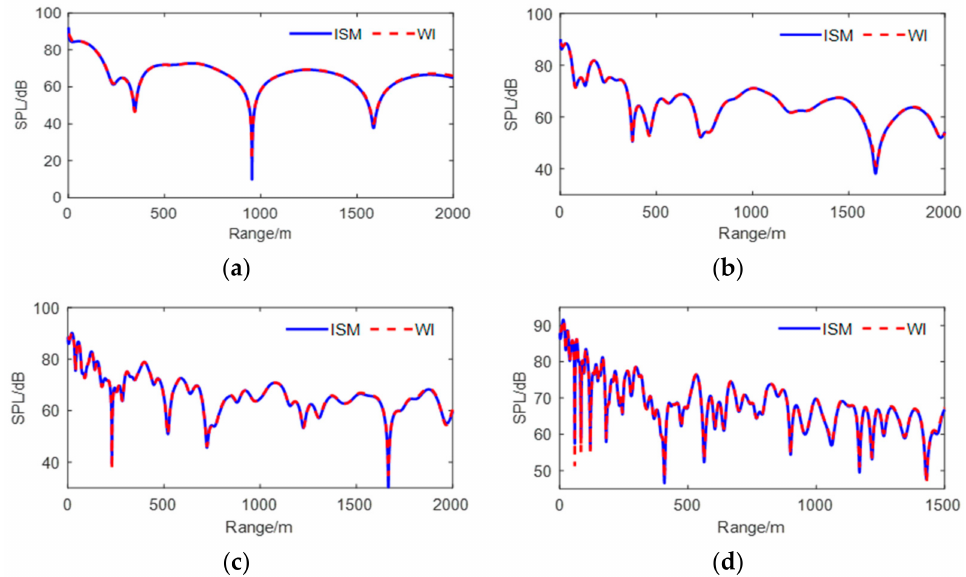
Figure 5. Sound field comparison between near- to far-field model and theoretical solution: integration method.